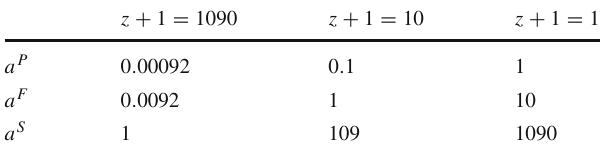
Table 2 Three conversions between scale factor and redshift z . a P follows the usual convention in cosmology. a S is used during our sim- ulations. a F is a fiducial one which relates the former two